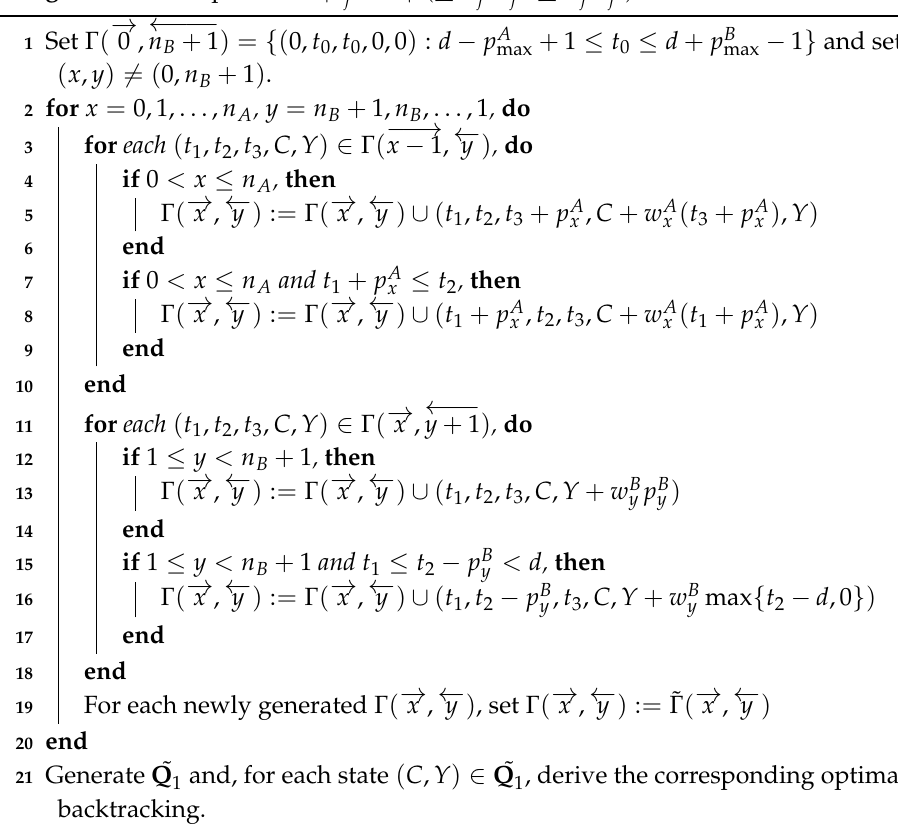
C A Y B , ∑ w B j j j j